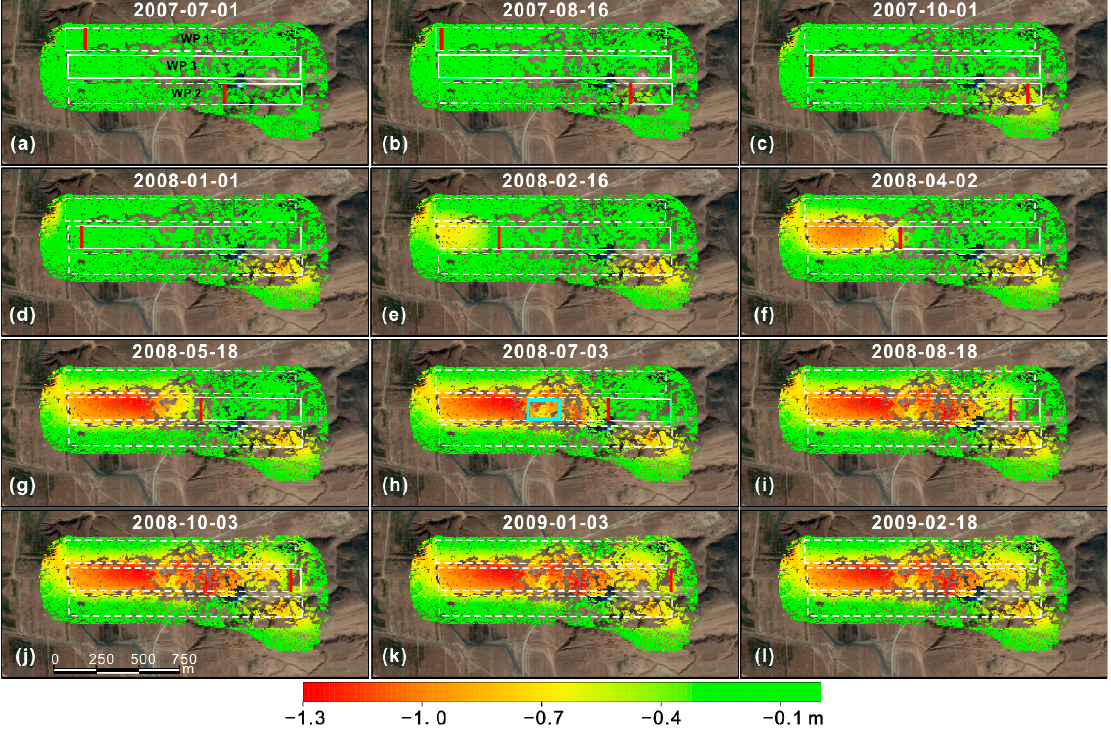
Figure 7. Estimated dynamic subsidence from 1 July 2007 to 28 February 2009 ( a – l ). The red lines denote the advancing locations of working panels WP1, WP2, and WP3 (see the white solid rectangles) at the times of the SAR acquisitions.